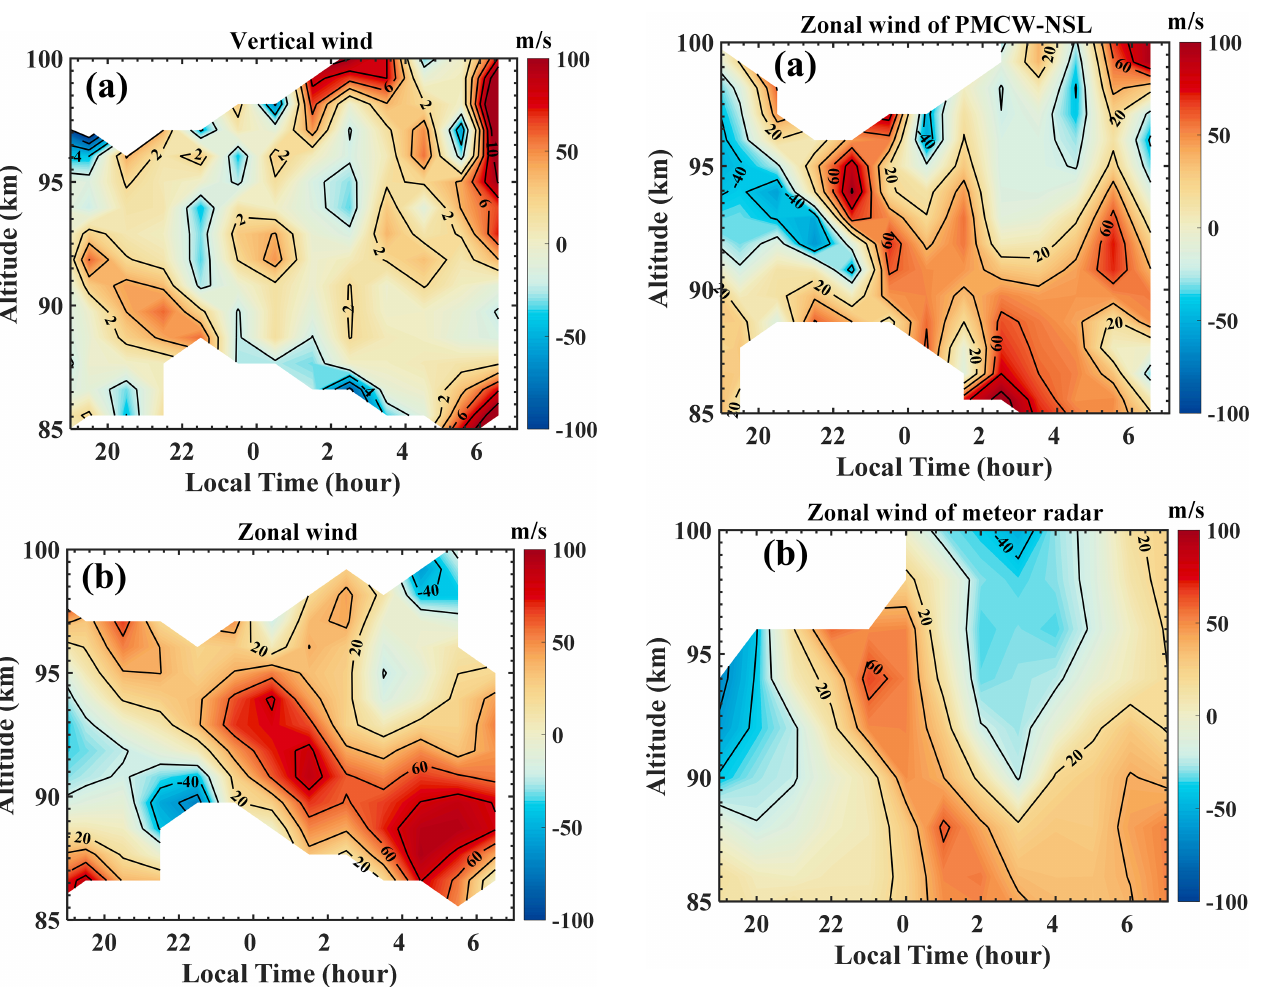
Figure 7. (a) Vertical wind and (b) zonal wind observed by the PMCW-NSL on 24 November 2021.